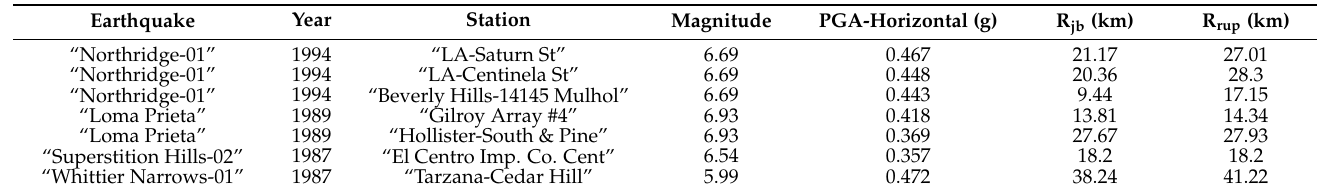
Table 6. Information of selected ground motion.